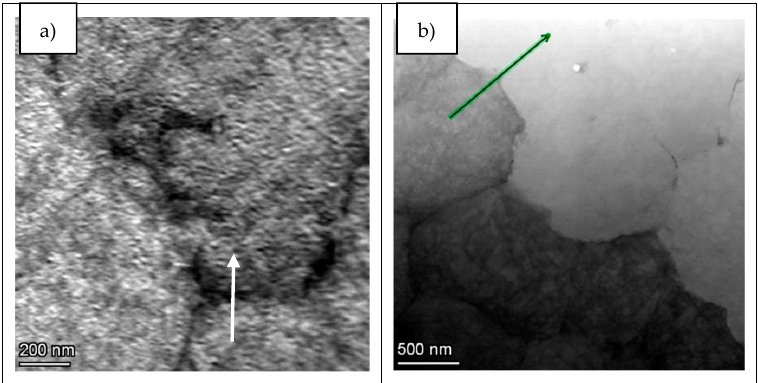
Figure 11. Identification of the zones for line-scans acquisitions: ( a ) LPW and ( b ) A&D.